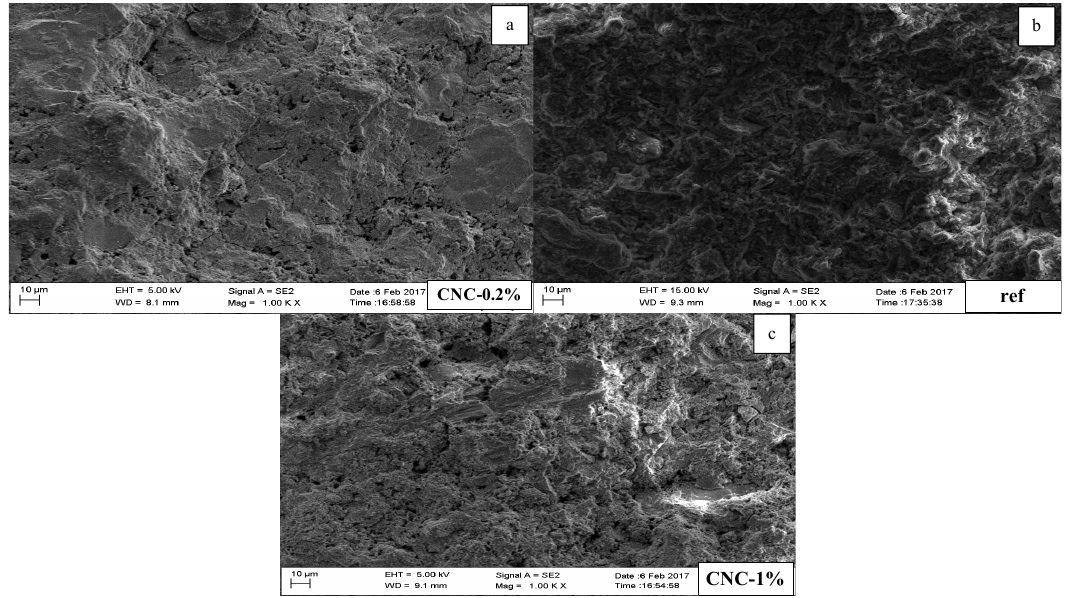
Figure 9. SEM images with 1000 resolution. ( a ) CNC-0.2% ( b ) reference sample ( c ) CNC-1%.